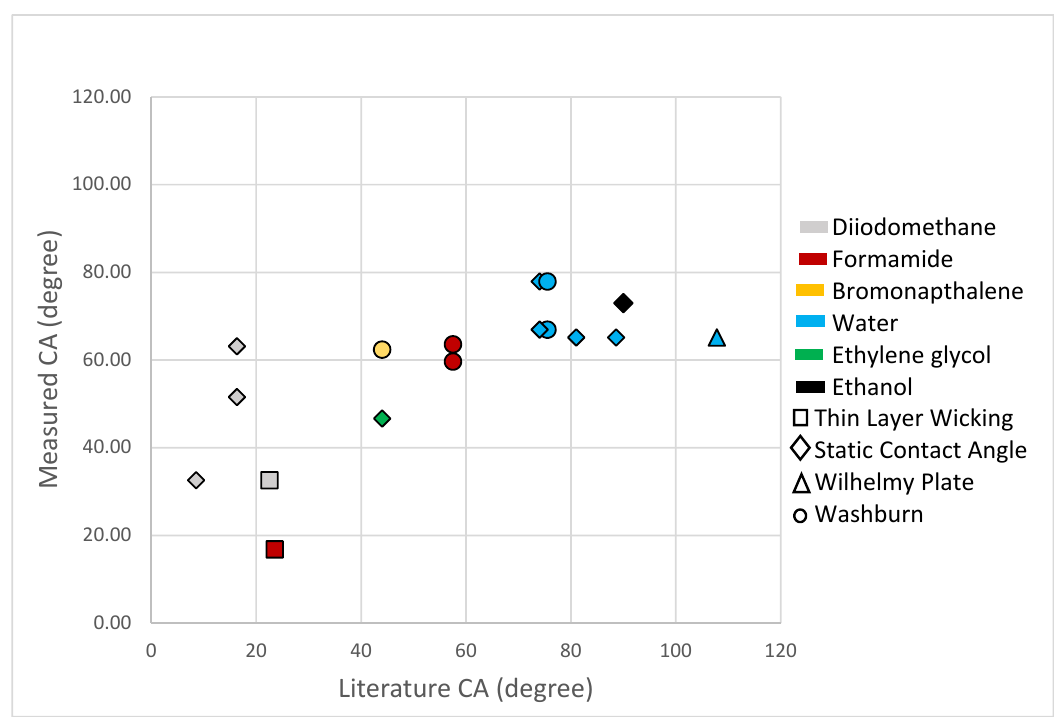
Figure 5. Comparison of the modified-DPM experimental values and literature contact angle values based on the type of technique used. The results have indicated that an obvious correlation between the experimental and literature contact angle values with any particular method could not be made. (The thin layer wicking method is a variation of the WCR method with powder deposited on a substrate.) Ideally, values would fall on a line with a slope equal to 1. This figure illustrates the challenge in obtaining reliable contact angles. Symbol shape represents measurement technique and color the solvent used for zinc oxide and titanium dioxide